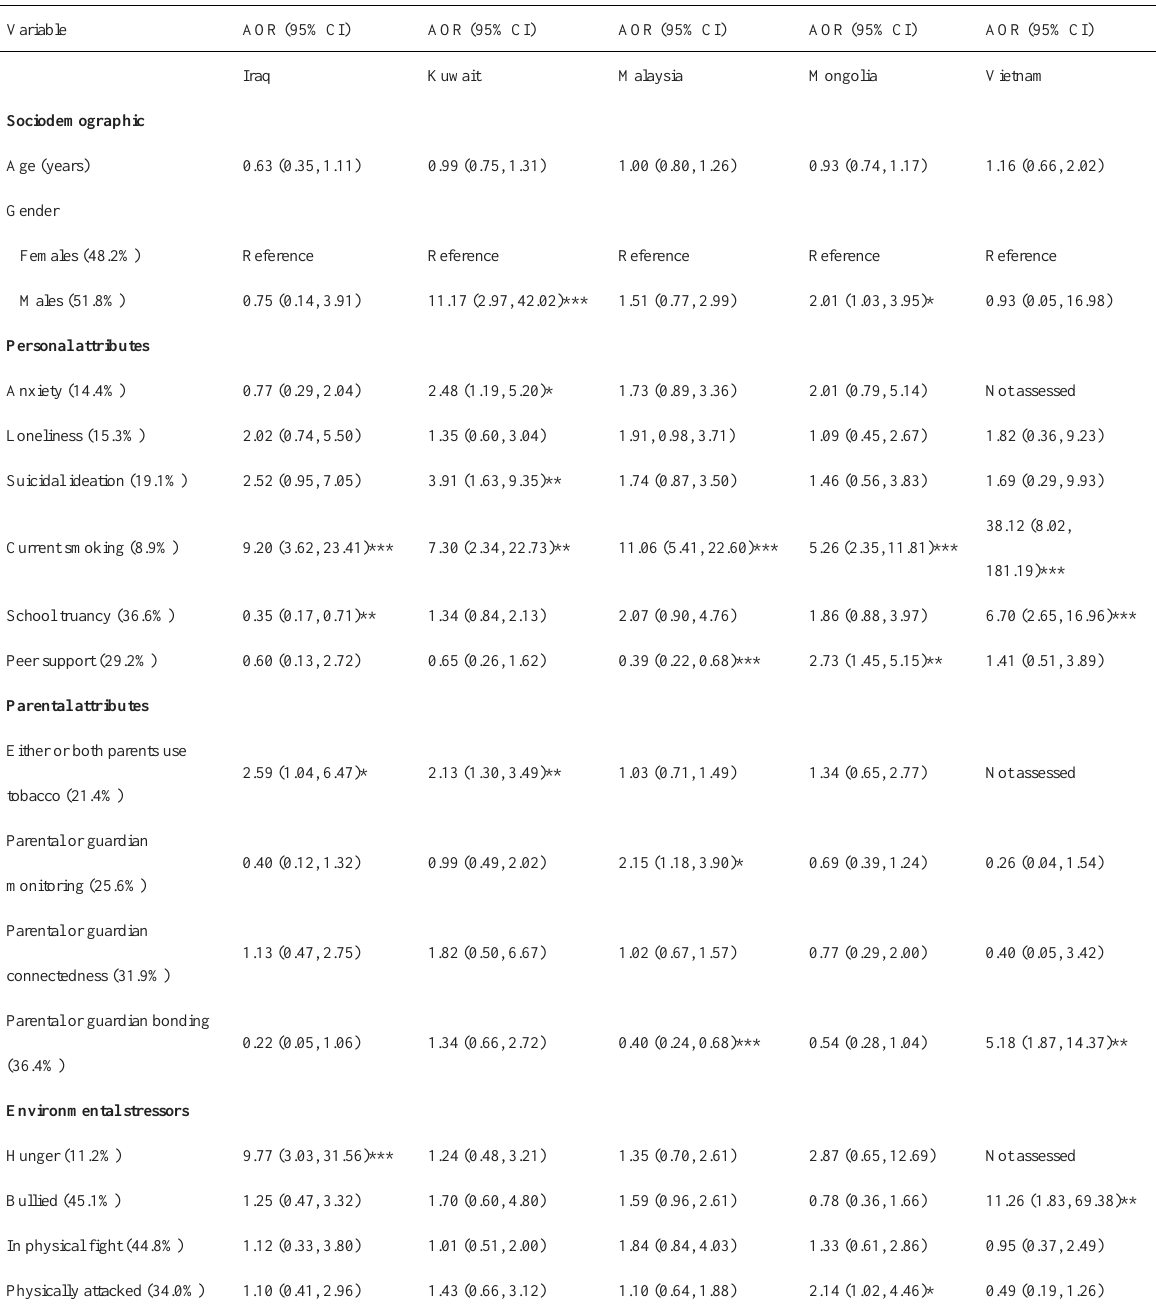
Table 3. Factors associated with lifetime cannabis